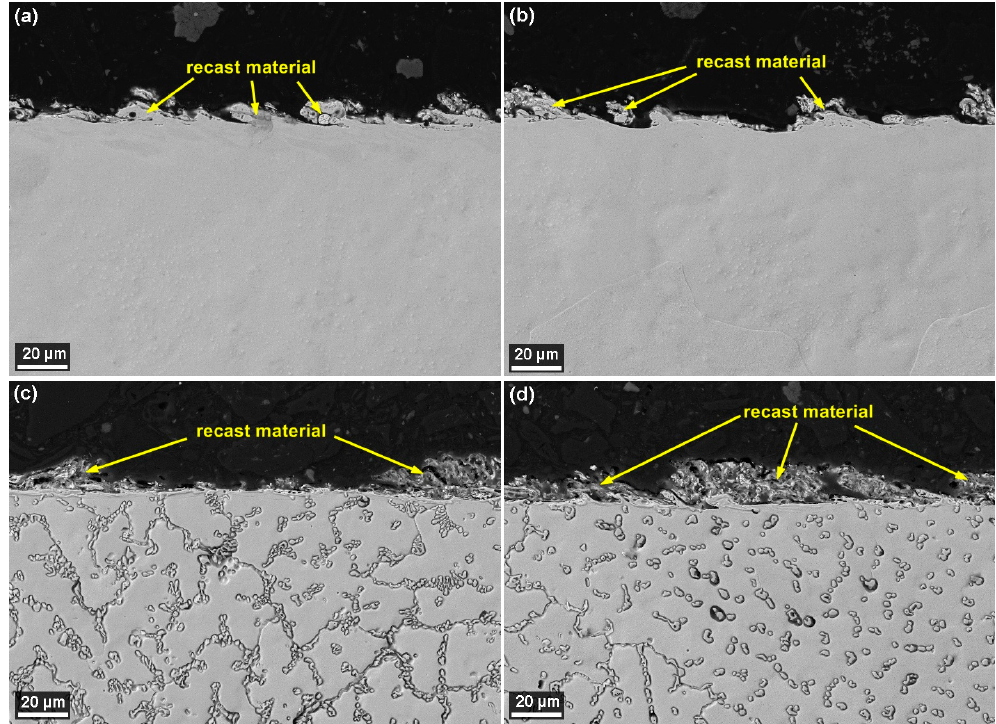
Figure 8. Crosssections of the SEM / BSE sample: ( a ) Sample 20 made of 1Fe alloy machined by the setting of the machine parameters: U = 70 V, T on = 6 µ s, T o ff = 50 µ s, v = 14 m / min, and I = 25 A; ( b ) Sample 14 made of 1Fe alloy machined by the setting of machine parameters: U = 70 V, T on = 10 µ s, T o ff = 30 µ s, v = 10 m / min, and I = 35 A; ( c ) Sample 20 made of 1Fe0.2C alloy machined by the setting of machine parameters: U = 70 V, T on = 6 µ s, T o ff = 50 µ s, v = 14 m / min, and I = 25 A; ( d ) Sample 14 made of 1Fe0.2C alloy machined by the setting of the machine parameters: U = 70 V, T on = 10 µ s, T o ff = 30 µ s, v = 10 m / min, and I = 35